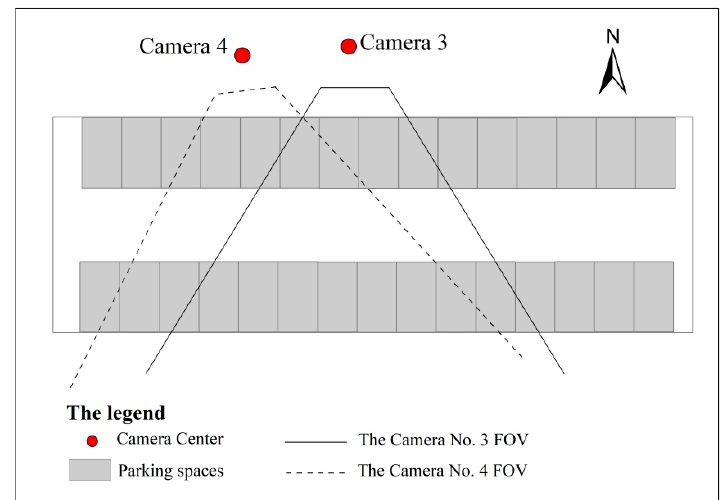
Figure 8. The 2D map of a parking lot.